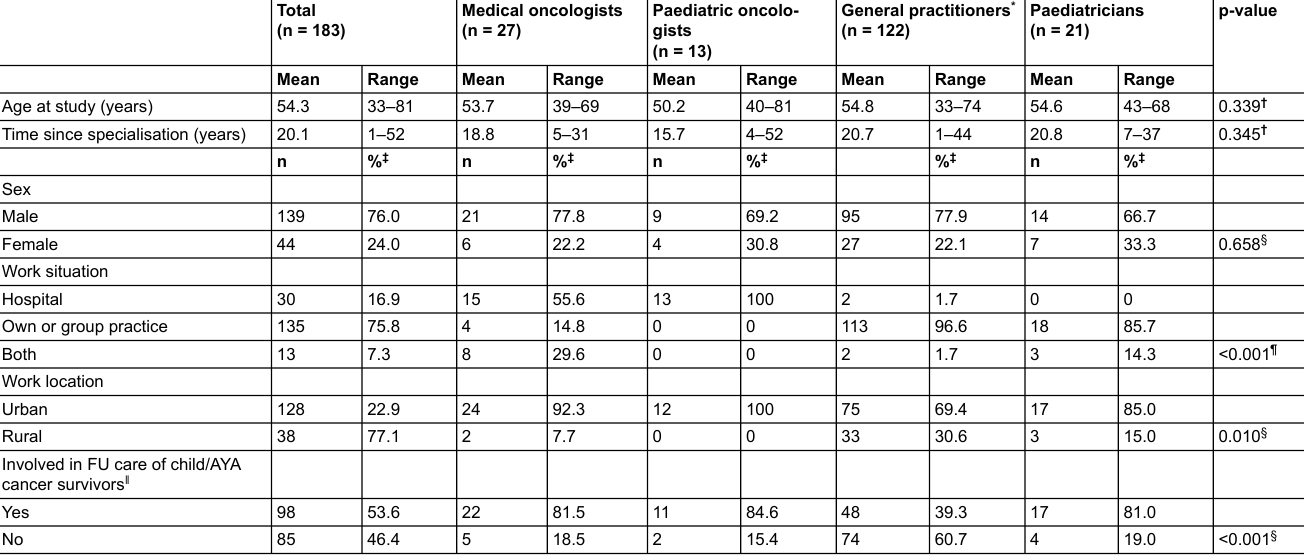
Table 1: Characteristics of physicians who participated in the study.